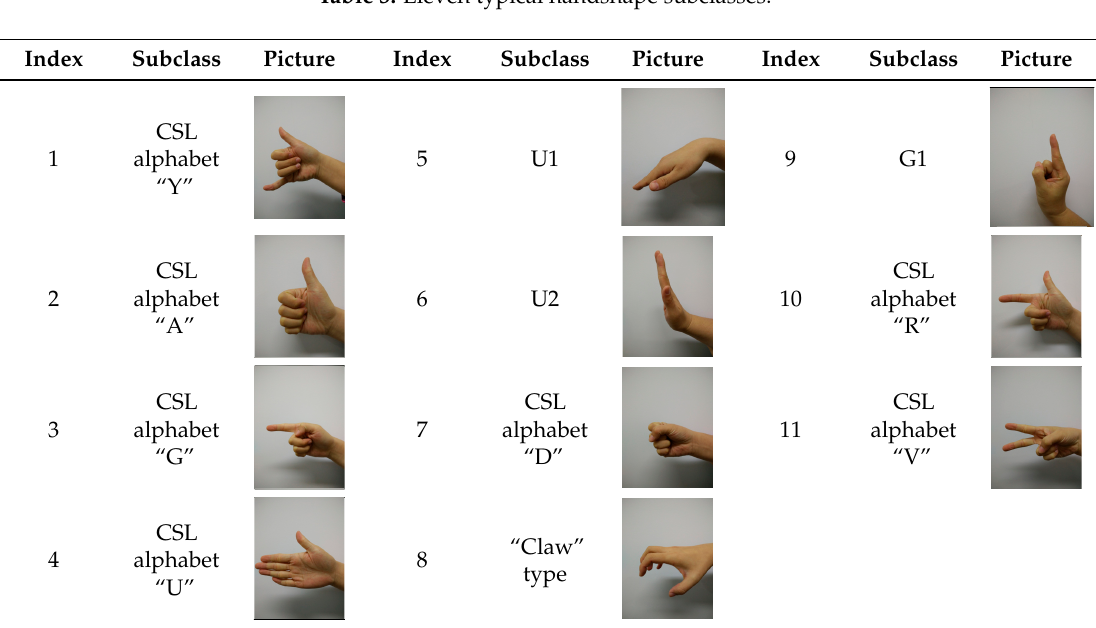
Table 4. Thirteen typical trajectory subclasses.